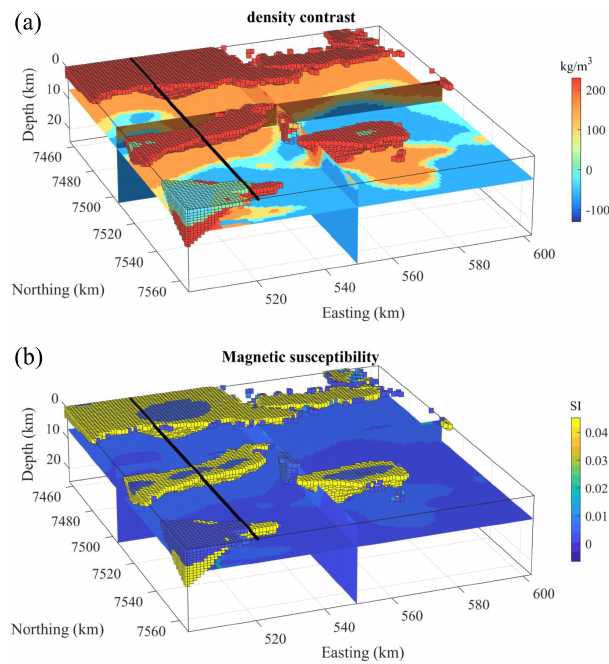
Figure 3. True synthetic density contrast (a) and magnetic suscep- tibility (b) model used for the simulation of geophysical data. The black line represents the surface coordinates of the 2D profile con- sidered here. The voxels represent lithologies 10 through 15, colour- coded with their respective density contrast and magnetic suscepti- bility